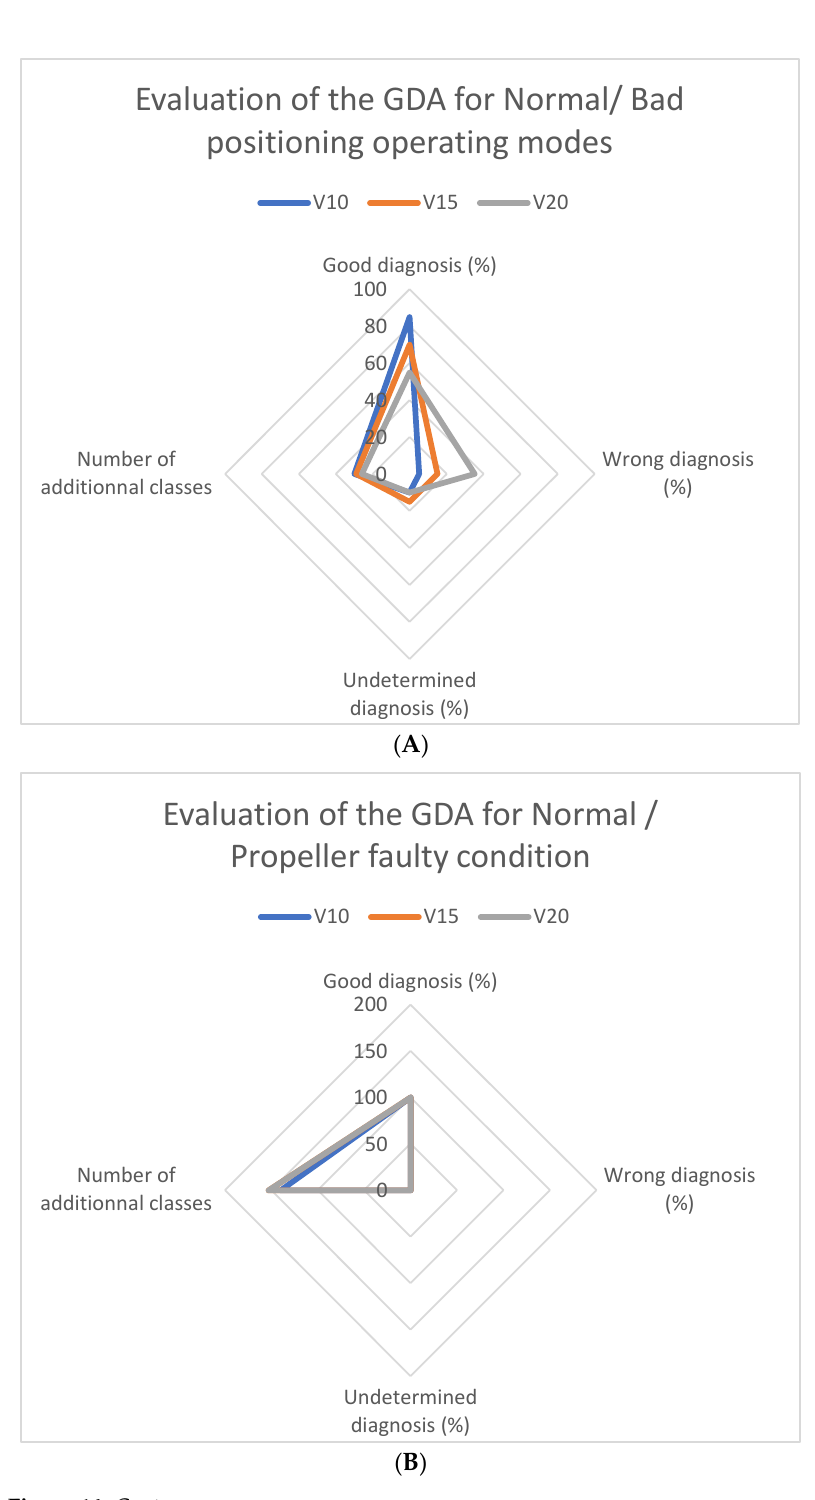
( C ) Figure 14. Evaluation of GDA for all operating modes. The A graph is for the comparison of the normal mode with the bad fan position. B is for the comparison between normal condition with the propeller faulty mode. C is for the comparison of bad fan position with propeller faulty mode.